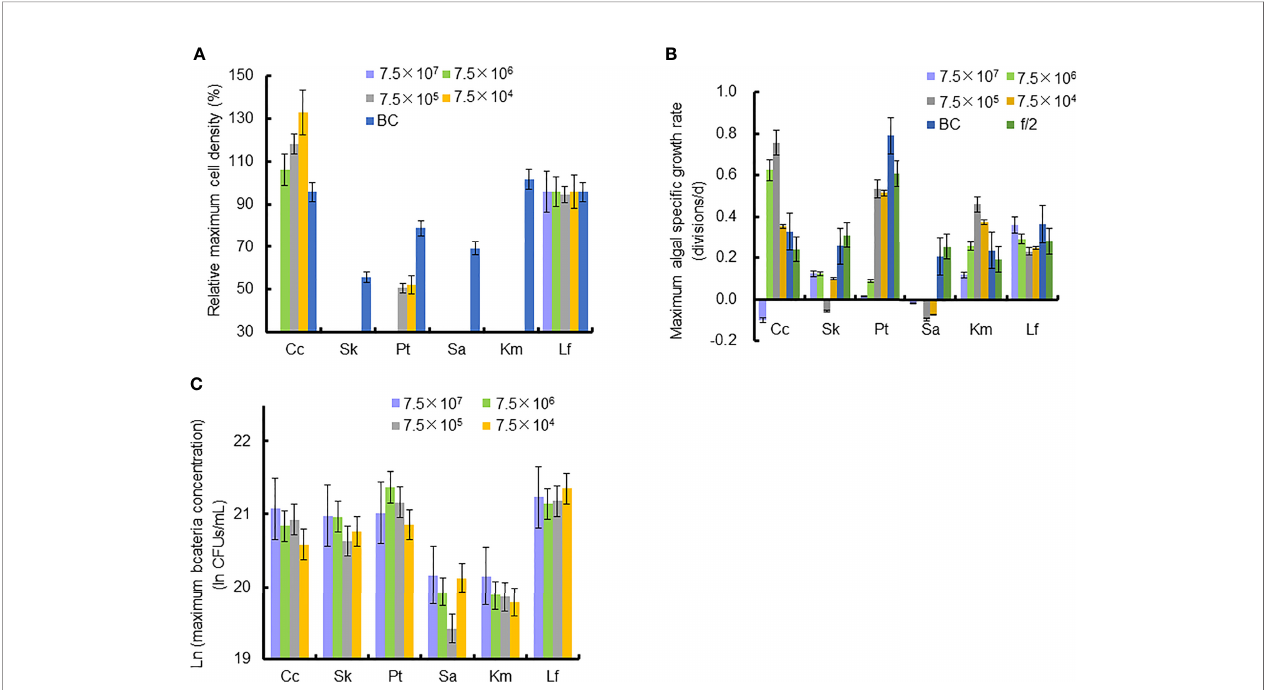
FIGURE 4 | Relative maximum algal cell density, maximum algal speci fi c growth rate, and bacteria concentration in co-cultures of six microalgal taxa with the bacterial strain Lf7 during the six days incubation. (A) Relative maximum algal cell density, (B) maximum algal speci fi c growth rate, (C) maximum Lf7 concentration in the algal cultures. Cc, co-culture of Chaetoceros curvisetus with Lf7; SK, co-culture of Skeletonema dohrnii with Lf7; Pt, co-culture of Phaeodactylum tricornutum with Lf7; Sa, co-culture of Scrippsiella acuminata with Lf7; Km, co-culture of Karenia mikimotoi with Lf7; Lf, co-culture of Levanderina fi ssa with